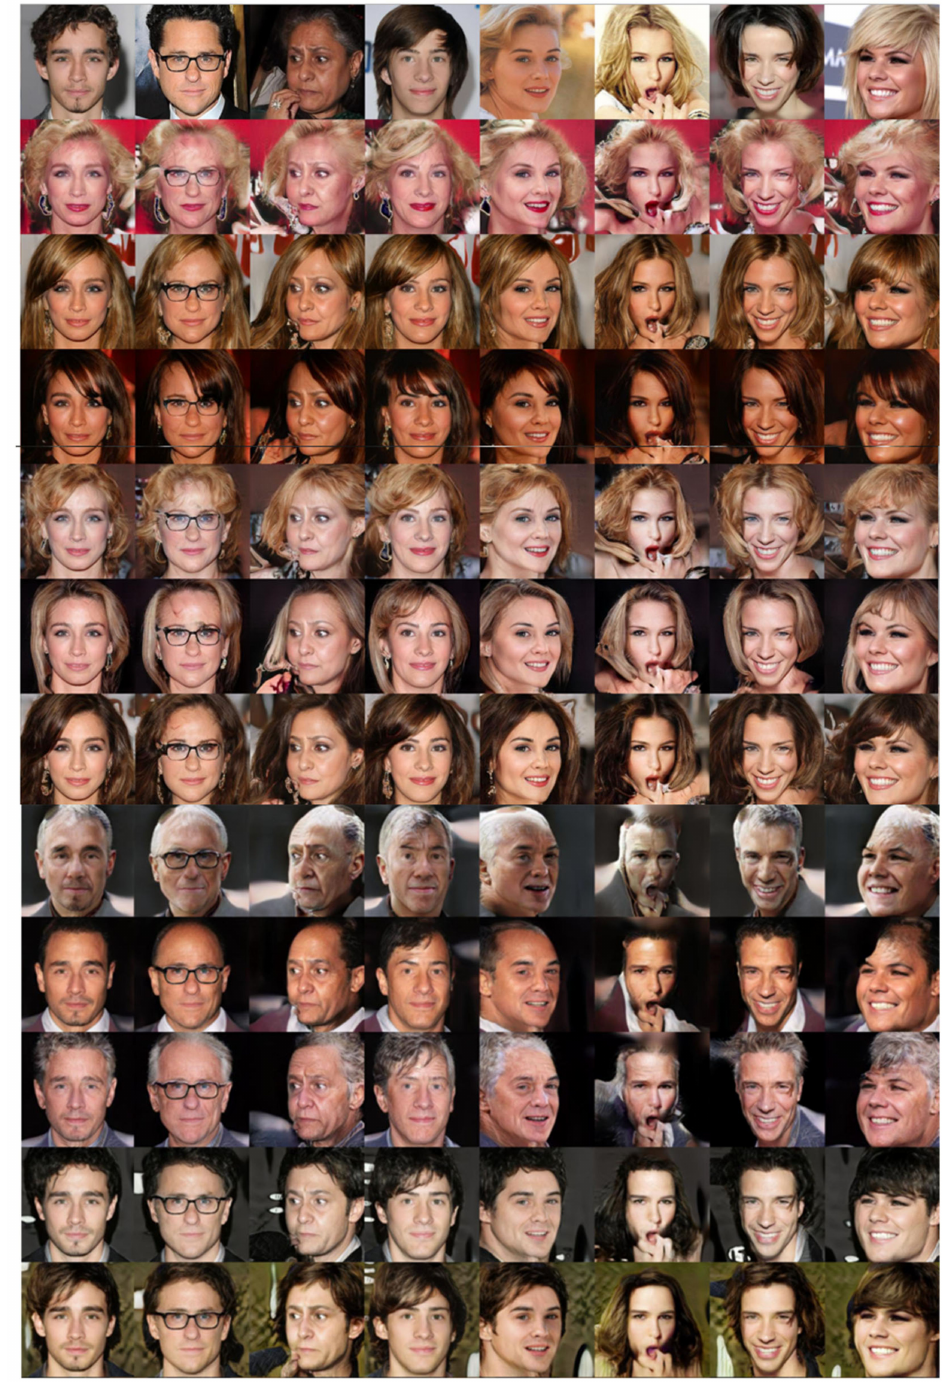
Figure A2. Using random noise to guide generated images s (The first row is the real